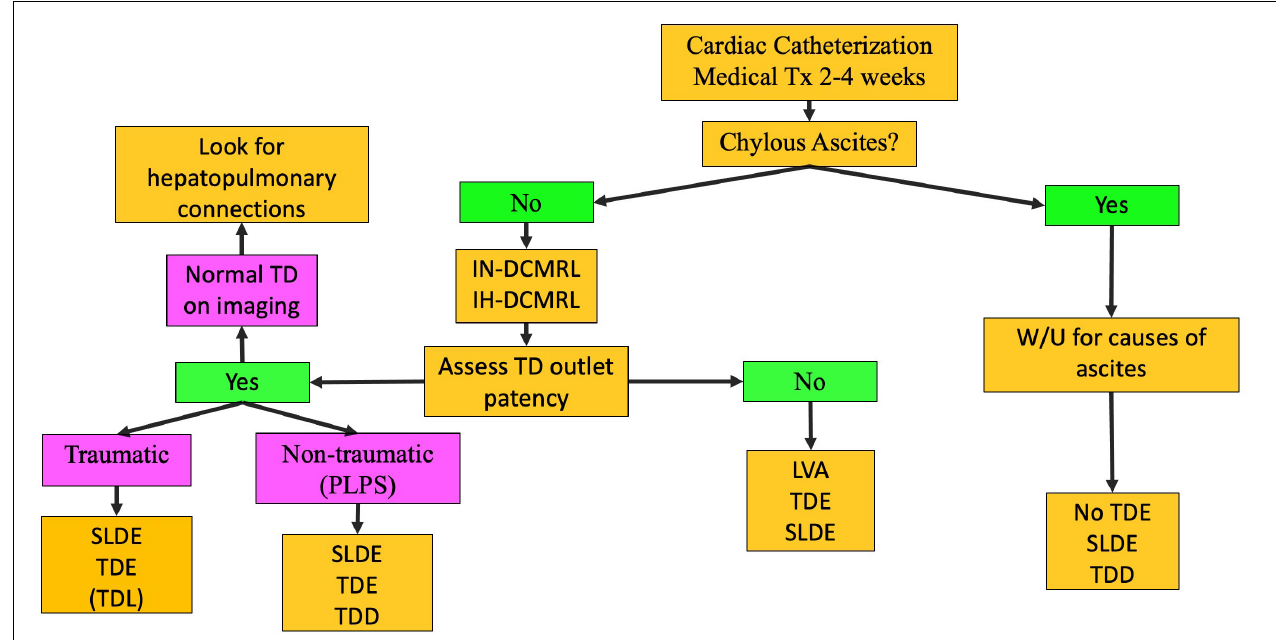
FIGURE 5 | Chylothorax treatment pathway (TD-thoracic duct, DCMRL-dynamic contrast lymphangiography, IN-intranodal, IH-intrahepatic, SLDE-selective lymphatic duct embolization, TDL-thoracic duct ligation, TDE-thoracic duct embolization, TDD-thoracic duct decompression, LVA-lymphovenous anastomosis, PLPS-pulmonary lymphatic perfusion